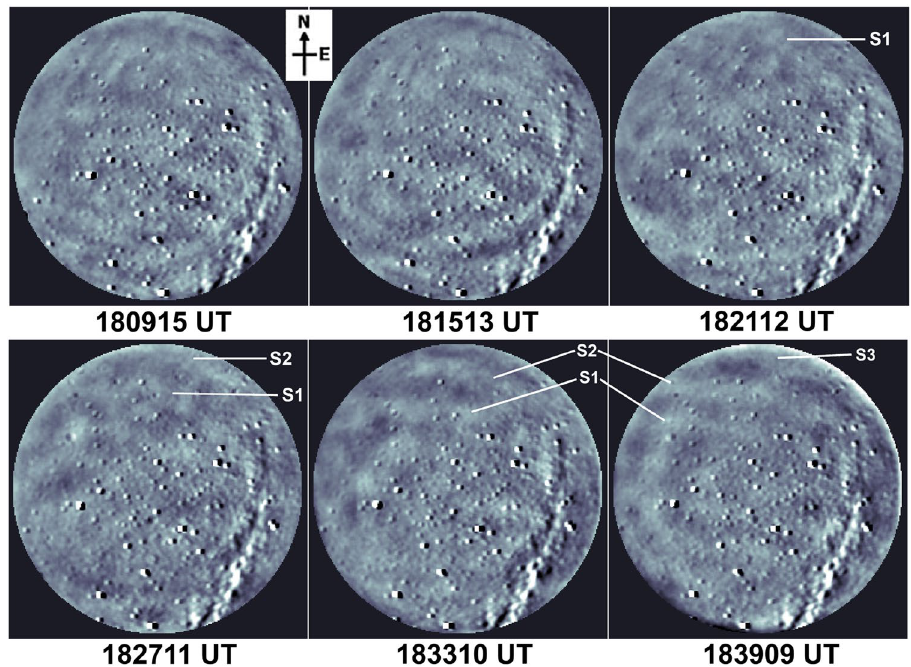
Figure 4. Same as Fig. 3 but for the interval 18:00–19:00 UT. GWs wavefronts arriving from the sprite occurrence location are indicated by S1, S2 and